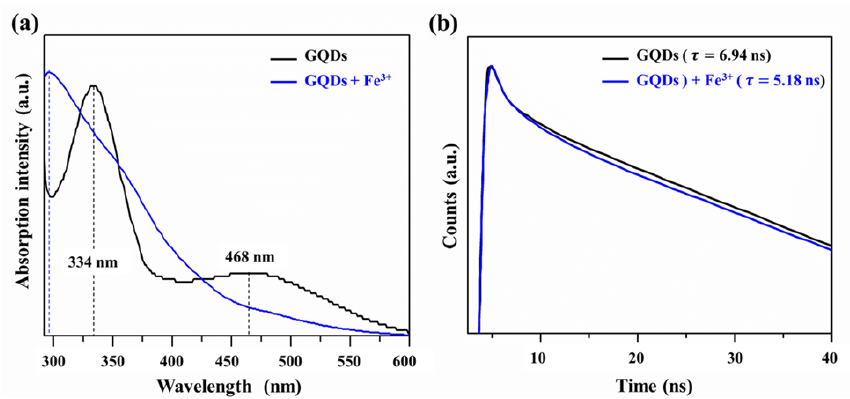
Figure A1. ( a ) UV-vis absorbance spectra of graphene quantum dots (GQDs) before/after the introduction of Fe 3 + under visible light and ( b ) fluorescence decay profile of GQDs and GQDs with 10 µ M of Fe 3 + . Table A1. Comparisons of the limit of detection (LOD) of Fe 3 + detection between nanocarbons in the present study with those previously